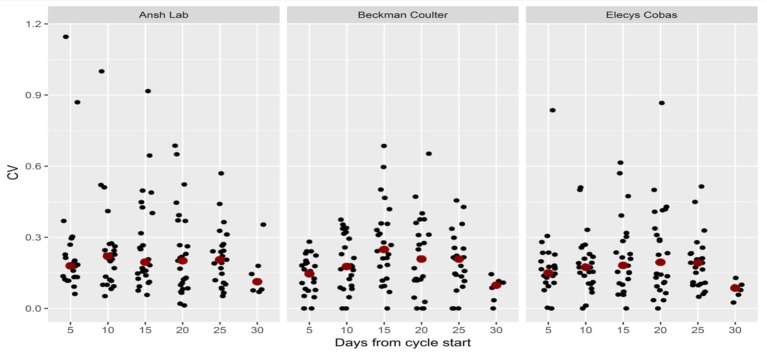
Coefficient of variation (CV) per cycleday in three assay-groups.